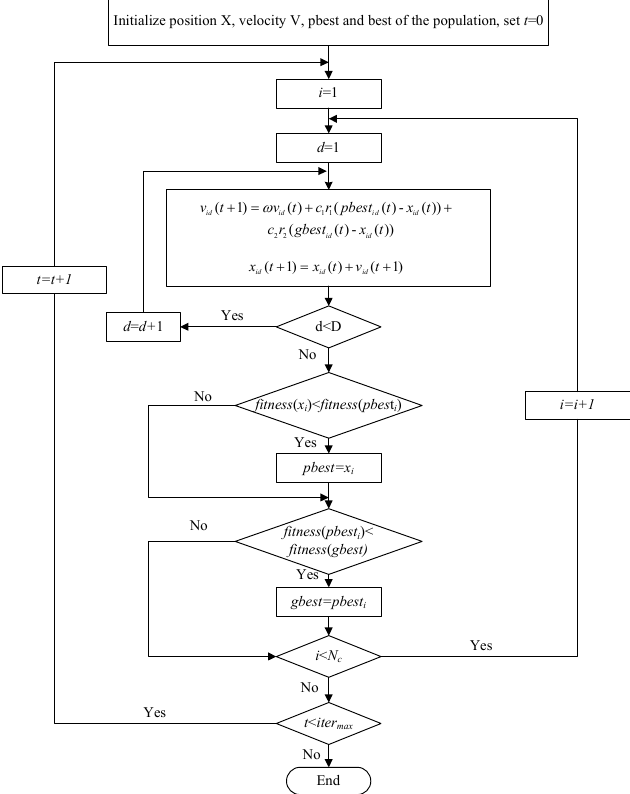
Fig. 1 Flowchart of the Standard PSO (Liang, Qin et al., 2006) Learning from the Genetic Algorithm (GA), a crossover operator has been used in the PSO to advance the global searching capability and to avoid running into local